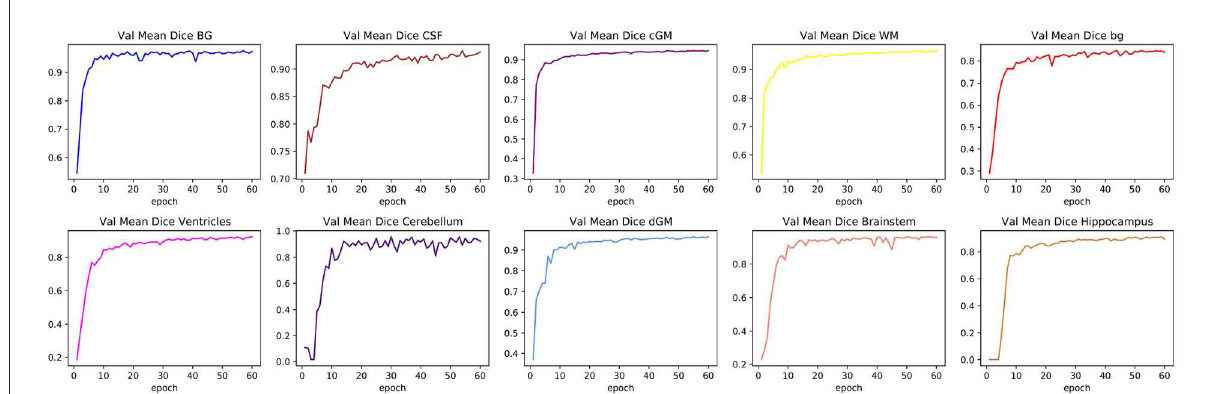
FIGURE6 Changes in validation DSC for all physiologically relevant tissues. The figure shows one particular run. The plots illustrate how a large proportion of the learning process took place within the first 20 epochs, and how some tissue classes can reach a plateau more quickly than others.